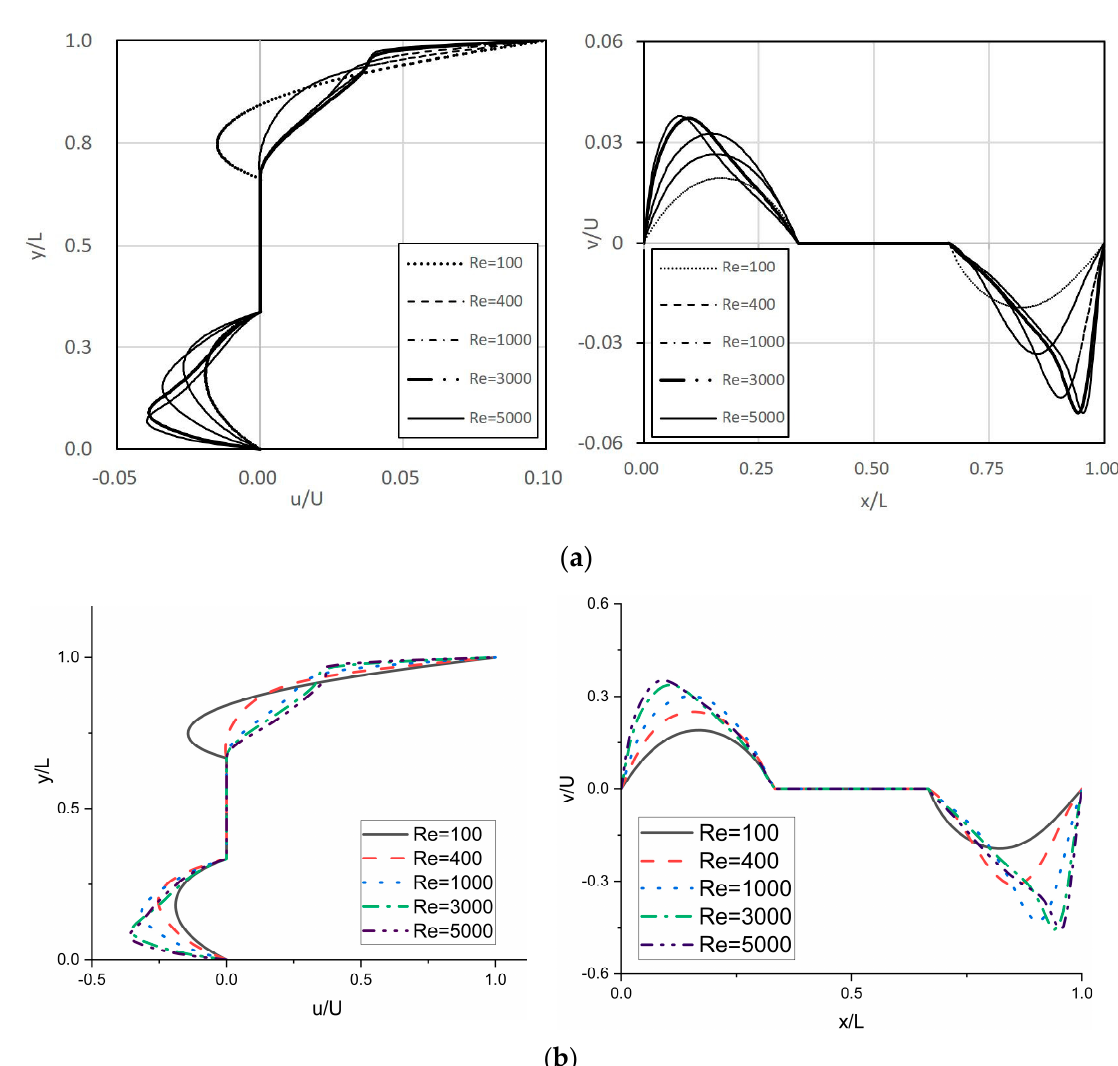
Figure 3. Comparison of the profiles of u-velocity and v-velocity in the lid-driven square cavity flow